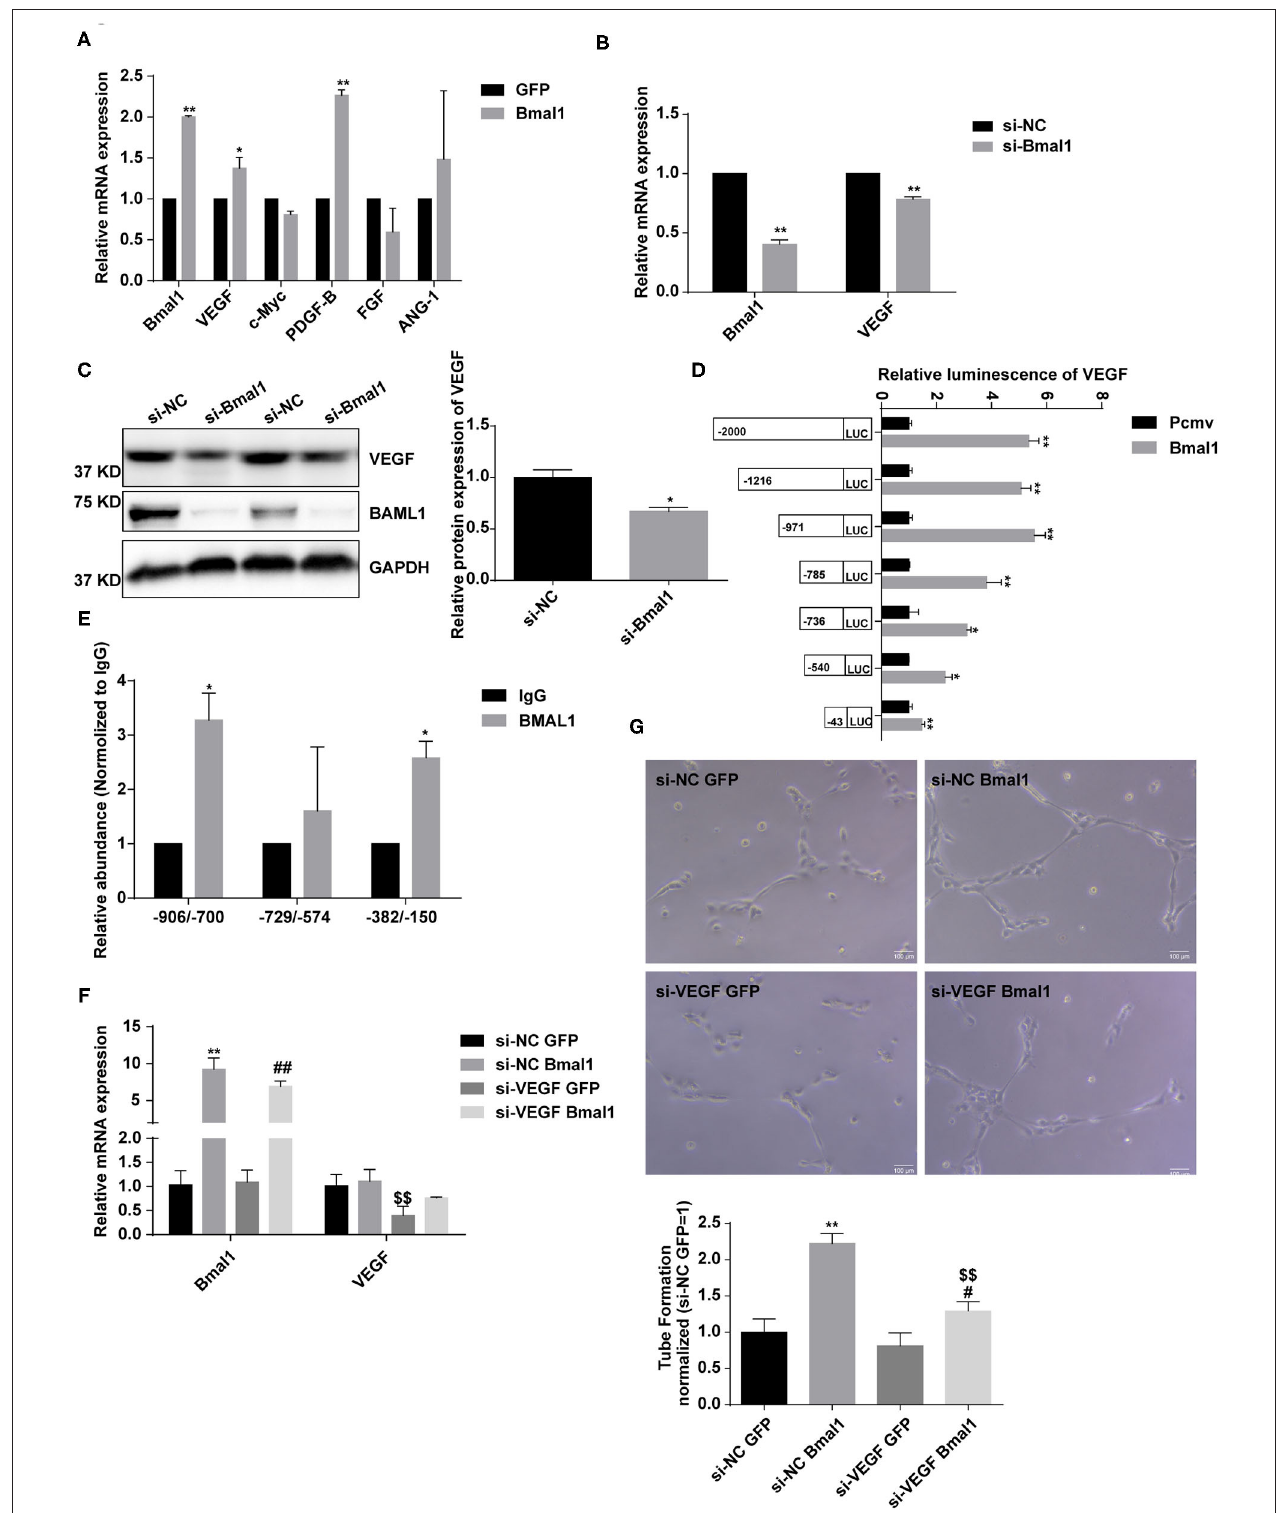
FIGURE 7 | Bmal1 promotes angiogenesis by transcriptionally regulating the vascular endothelial growth factor (VEGF) expression. (A) Relative mRNA expression of genes involved in angiogenesis in human umbilical vein endothelial cells (HUVECs) which had been transfected with adenoviruses coding for AdGFP or